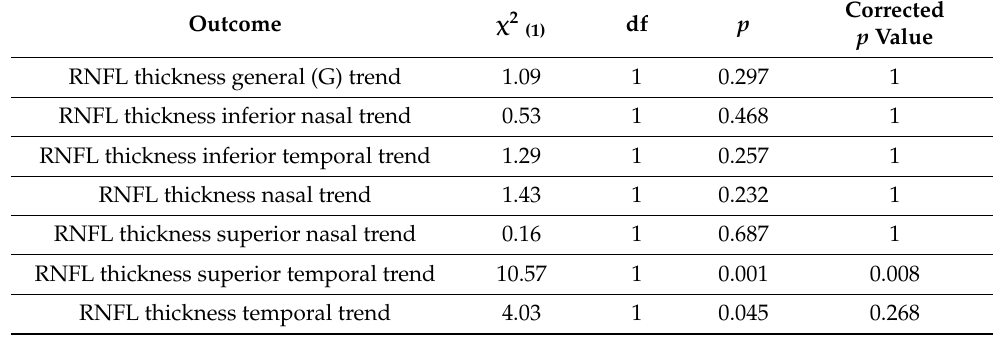
Table 3. Comparison of model fit for the baseline and full model using likelihood ratio test. The pRNFL was statistically significantly thinner in the temporal and temporal superior field in the LHON group in comparison to the nonLHON group.